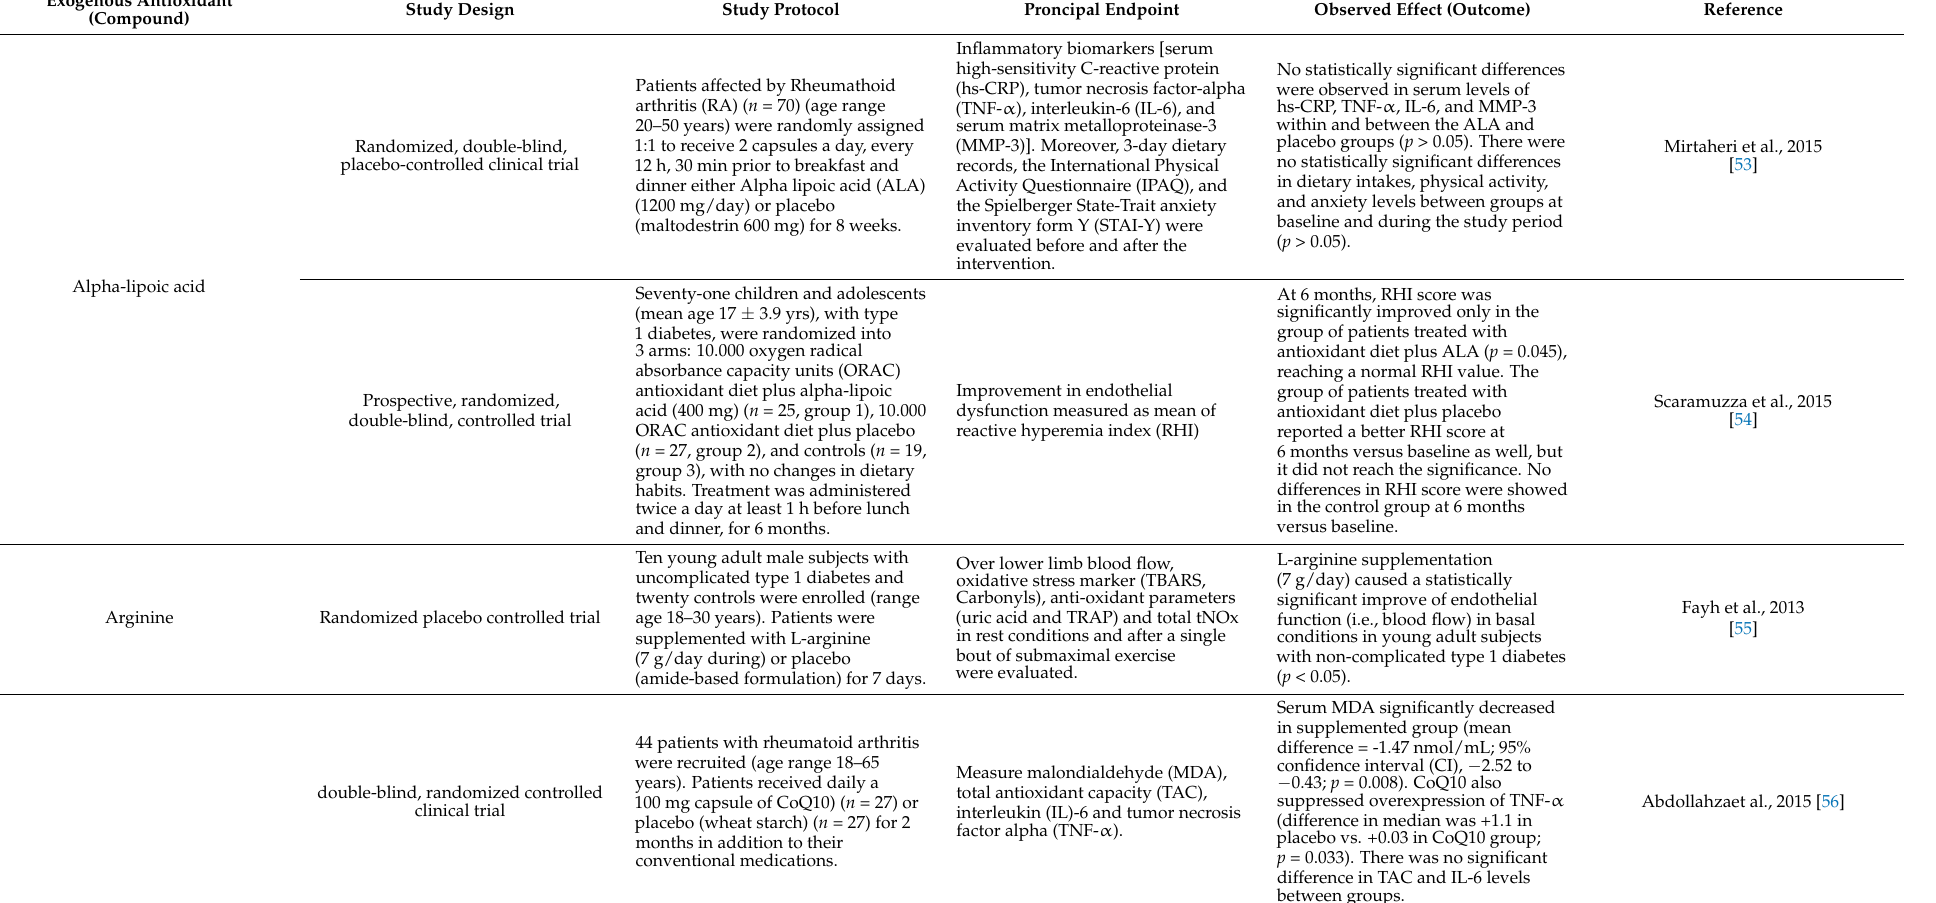
Table 1. Clinical studies supporting the use of the exogenous antioxidant compounds (considered), in autoimmune